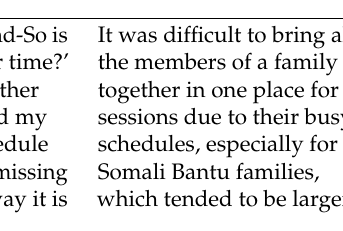
Table 6. Joint display table: Integration of quantitative (percent of caregivers reporting construct) and qualitative (interview data) about feasibility of the intervention. Quantitative Results Qualitative Results Interpretation